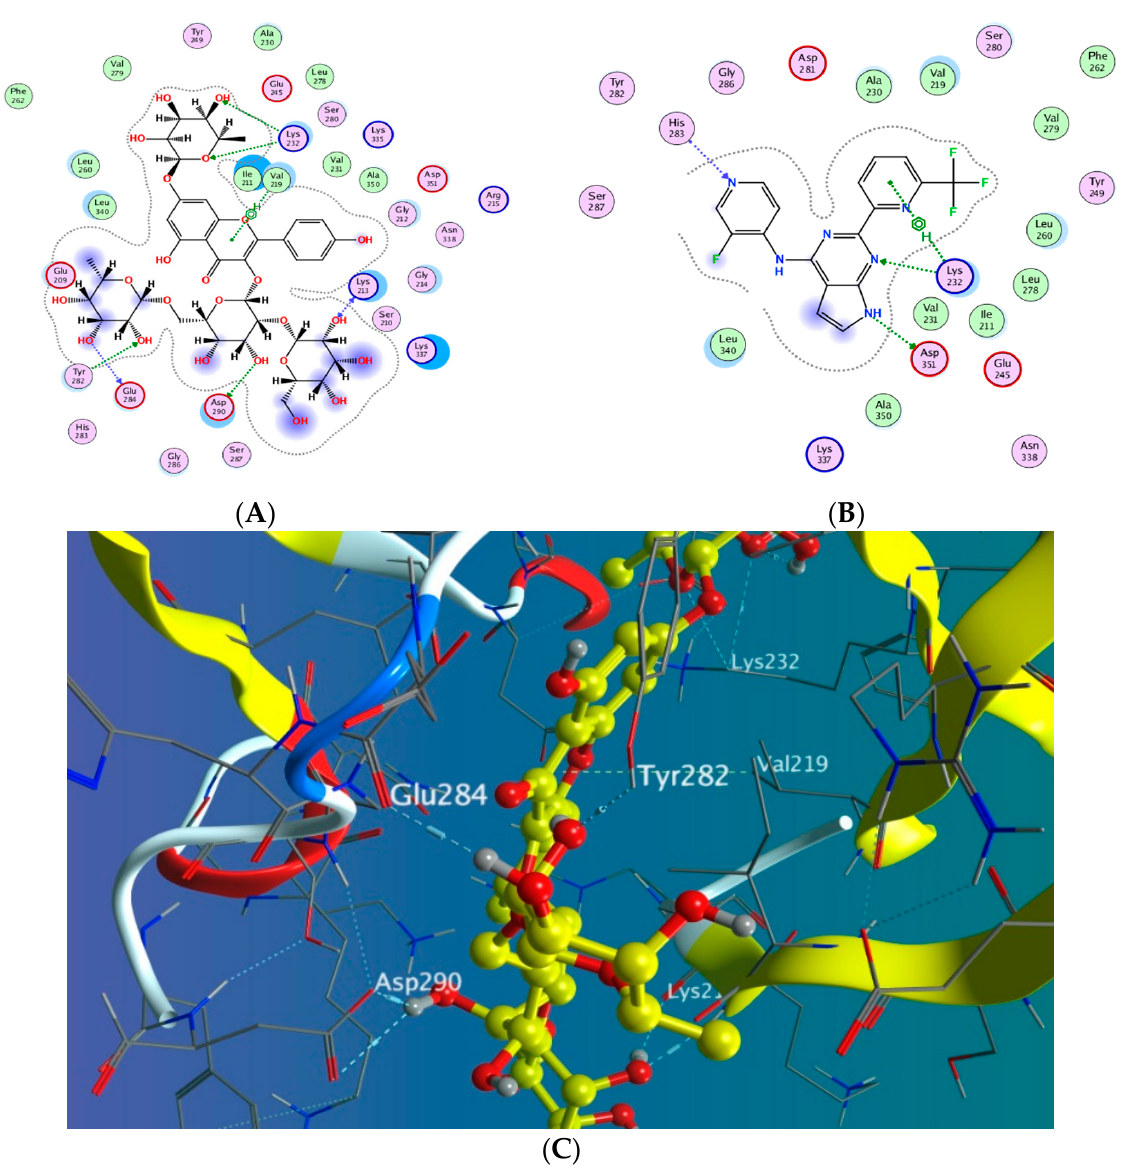
Figure 9. Docking results of compound 14 in the active pocket site of (TGF- β ) (6B8Y): ( A ) 2D interactions of ligand; ( B ) 2D interactions of compound 14 ; ( C ) 3D Docking pose of compound 14